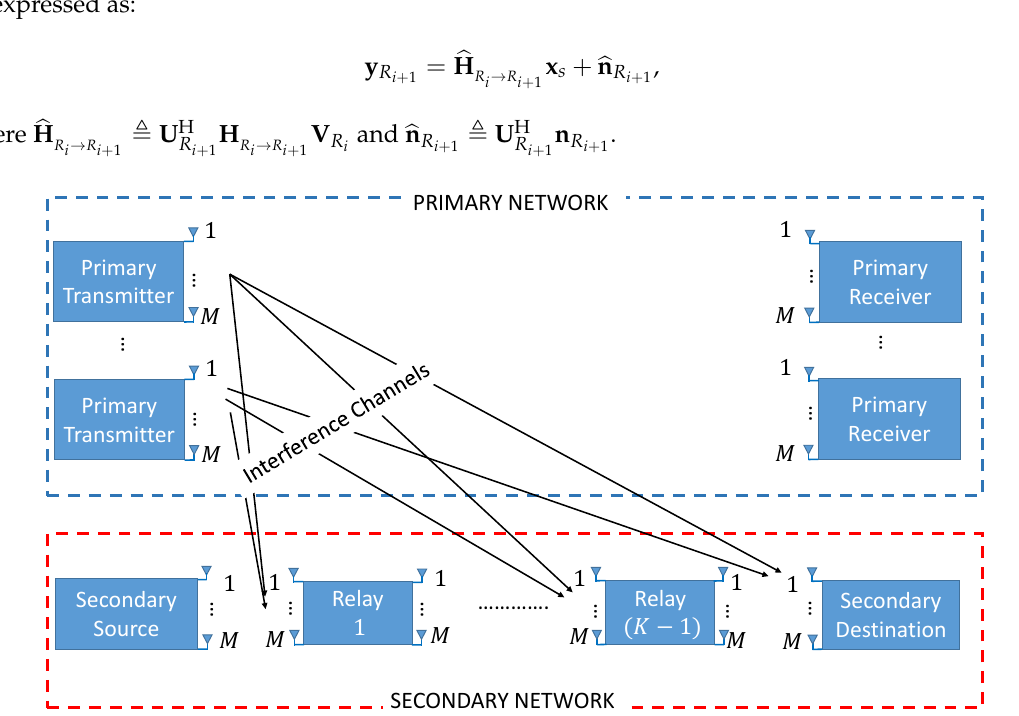
Figure 1. Multi-hop underlay cognitive radio network.